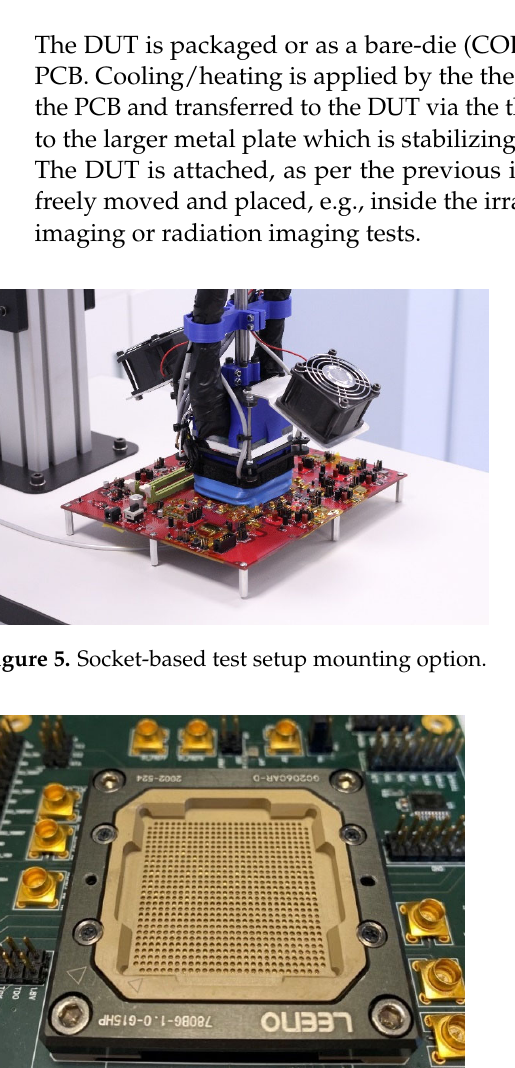
Figure 6. Example of supported sockets (pogo-pin socket for BGA package with clamshell lid removed).